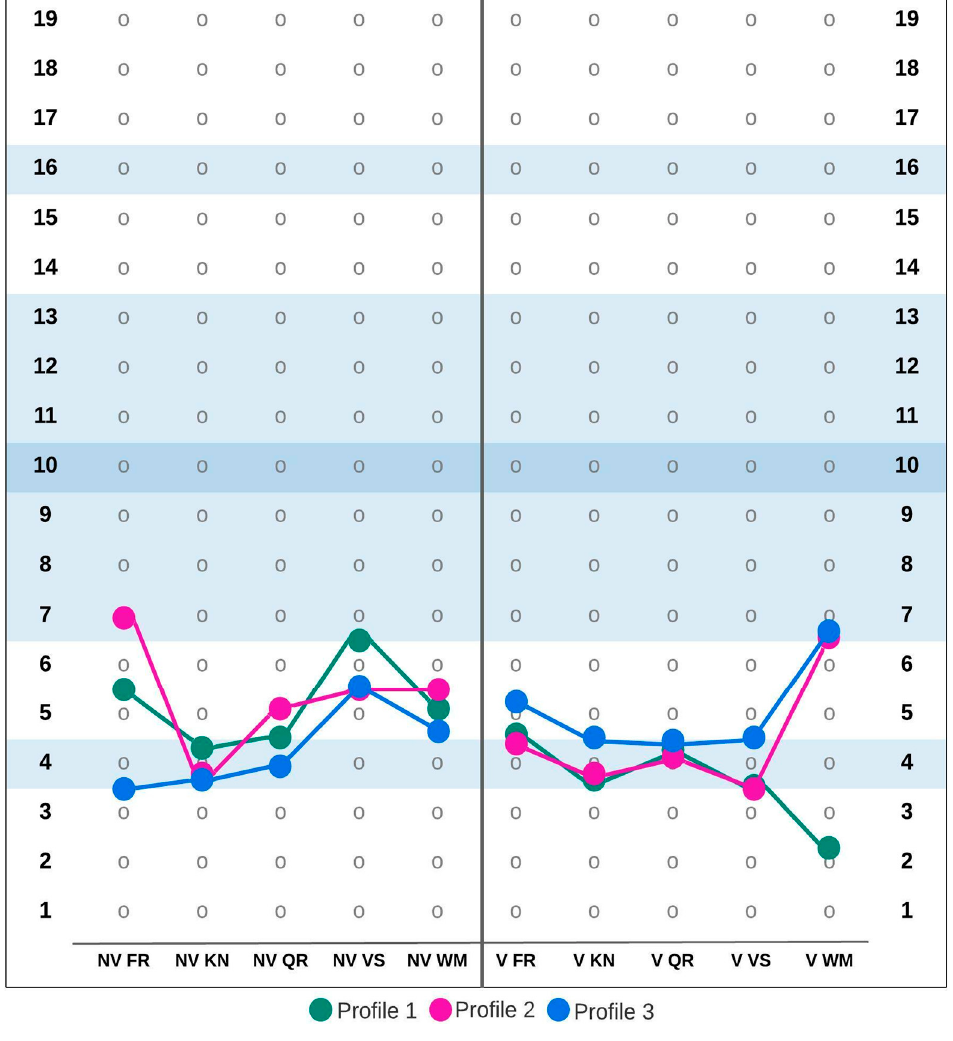
Table 2. Cluster centers (the arithmetic mean of all the observations belonging to the cluster) for 10 SB5 subtests on a standardized scale of 1 – 19.